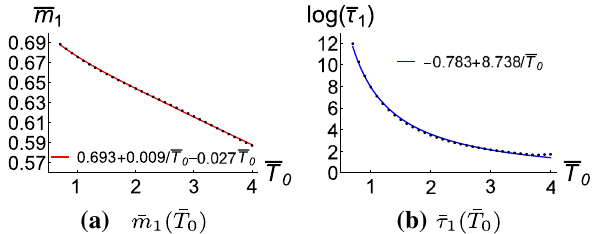
(cid:14) Fig. 14 The relations of the scaled mass ¯ m 1 and the scaled life- ¯ T 0 . time ¯ τ 1 of the first resonance with the parameter ¯ T 0 for f ( T ) = k 2 − ¯ T 0 . The dots are calculated values while the red and k 2 blue lines are fit functions. The parameter is set to ¯ b = 10 8 . 738 log ( ¯ τ 1 ) = − 0 . 783 + ¯ T